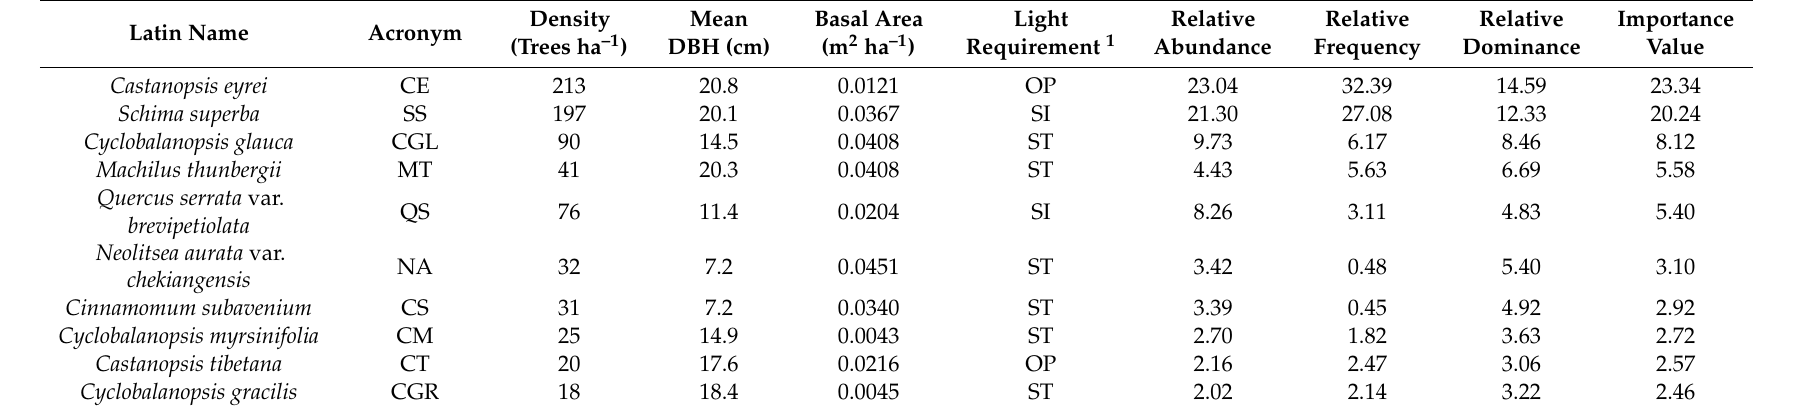
Table 1. The importance values and characteristics of the top ten dominant tree species in the old-growth